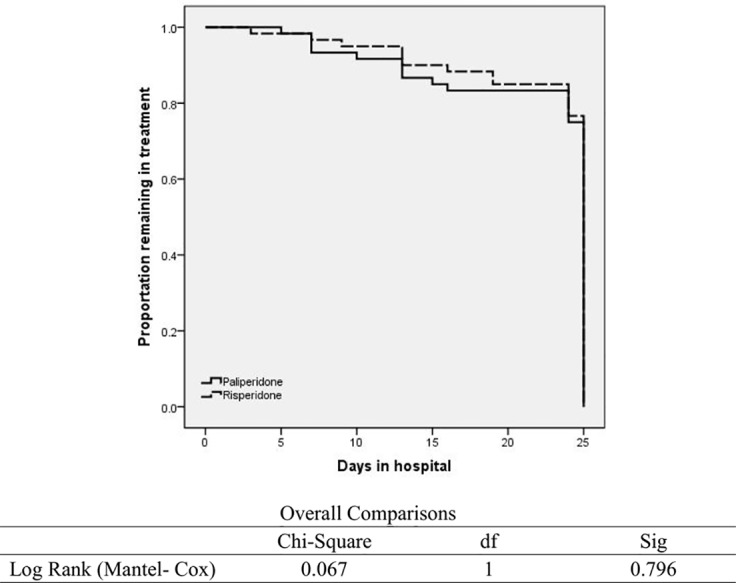
Kaplan-Meier survival curves with proportion of patients remaining in treatment in the two study group.